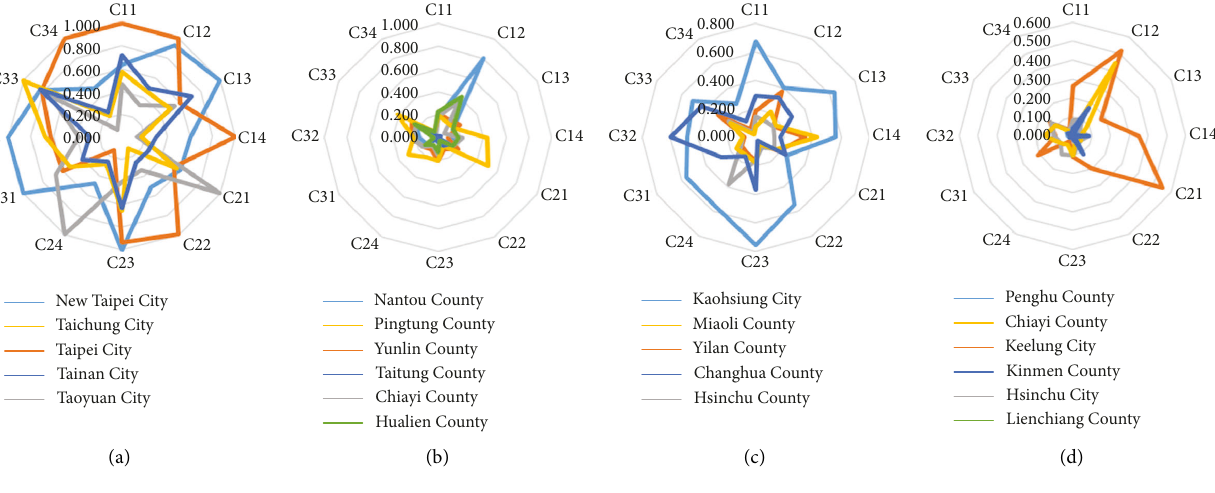
Figure 3: Normalized public safety data for each city and county.